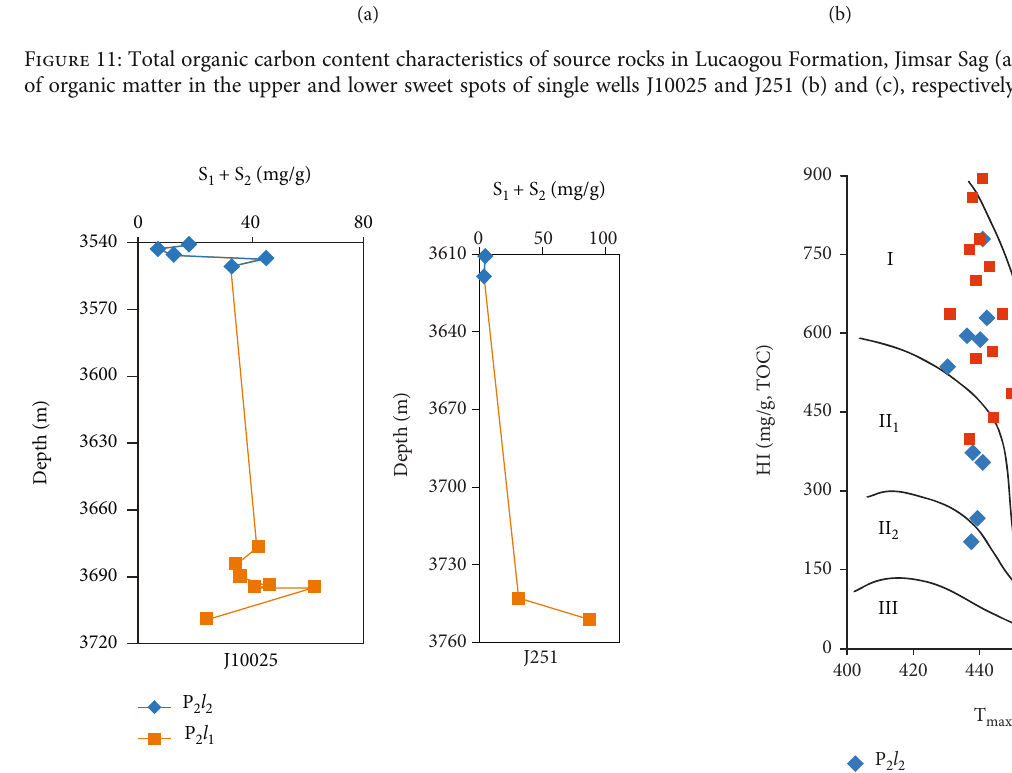
Figure 12: Hydrocarbon generation potential of source rocks in Lucaogou Formation, Jimsar Sag.